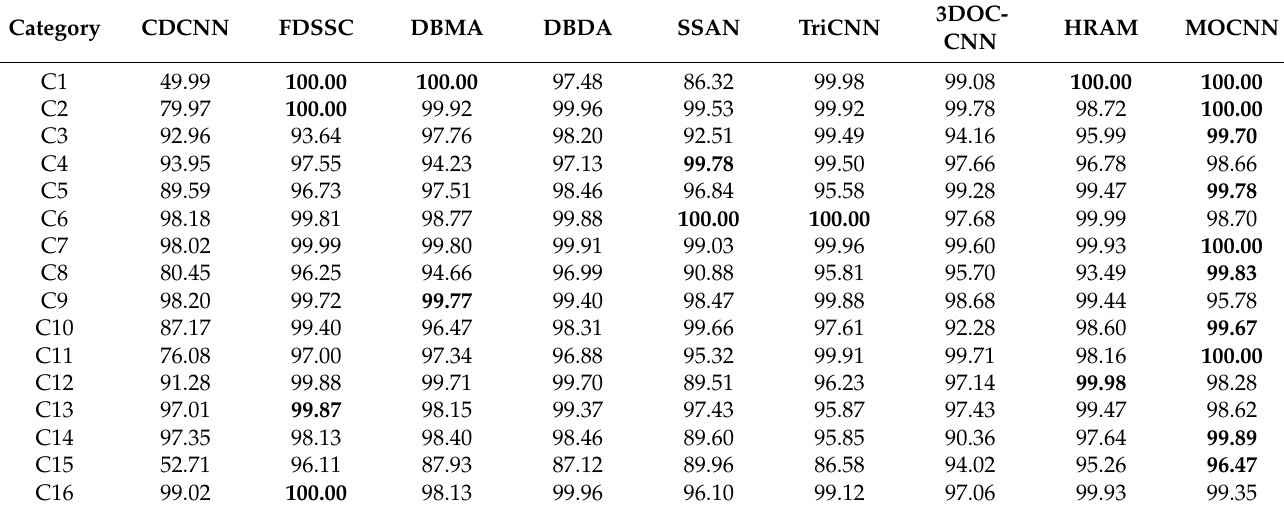
Table 8. Quantitative comparison of the CDCNN [30], FDSSC [31], DBMA [34], DBDA [35], SSAN